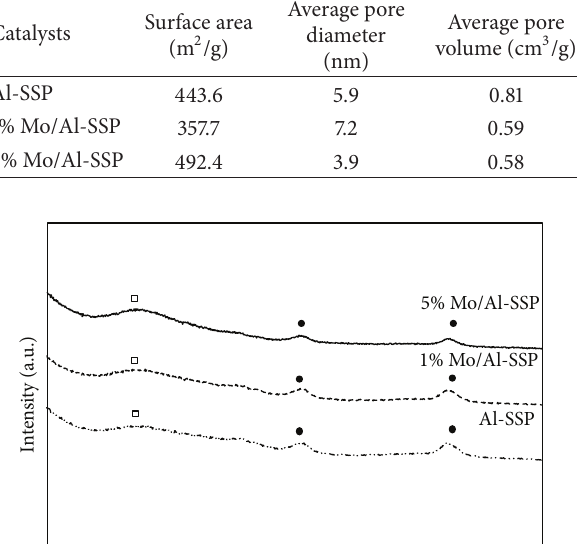
Figure 2: Nitrogen adsorption/desorption isotherms of all catalysts.